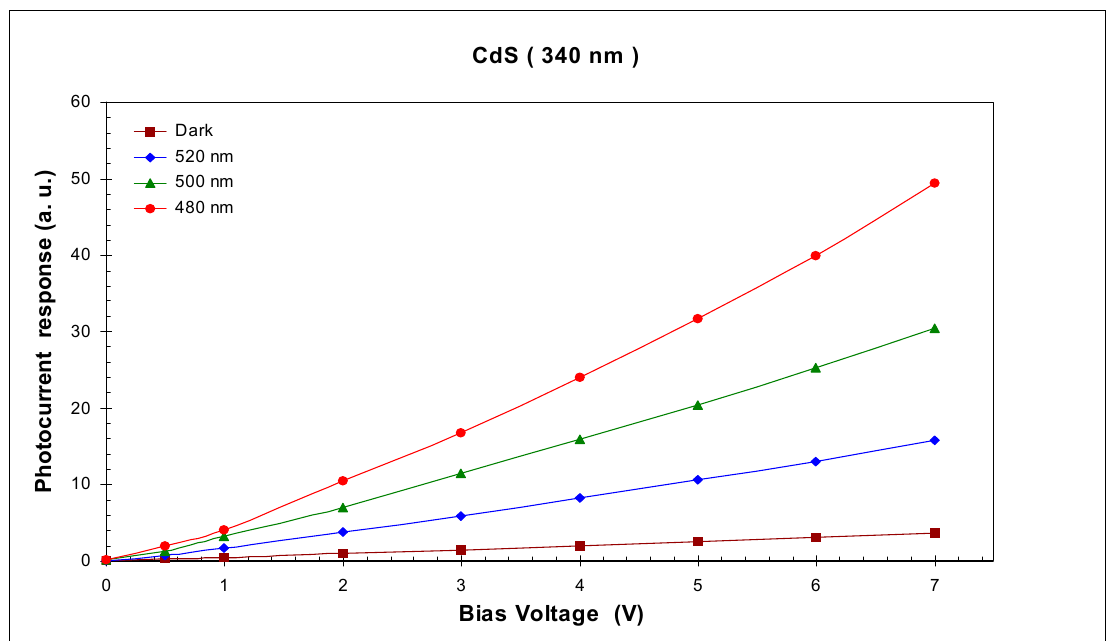
same bias voltage.